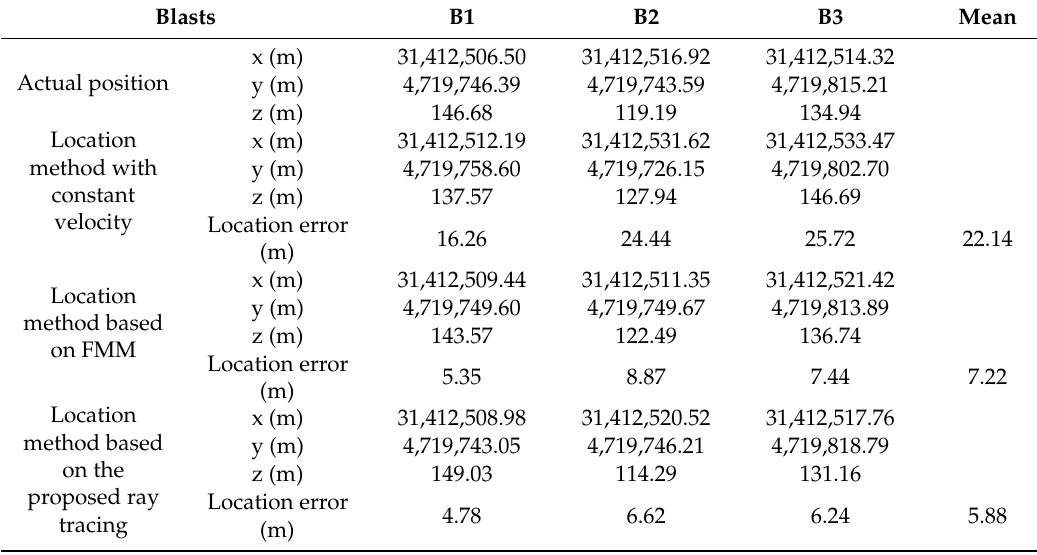
Table 4. Location results of the controlled blast